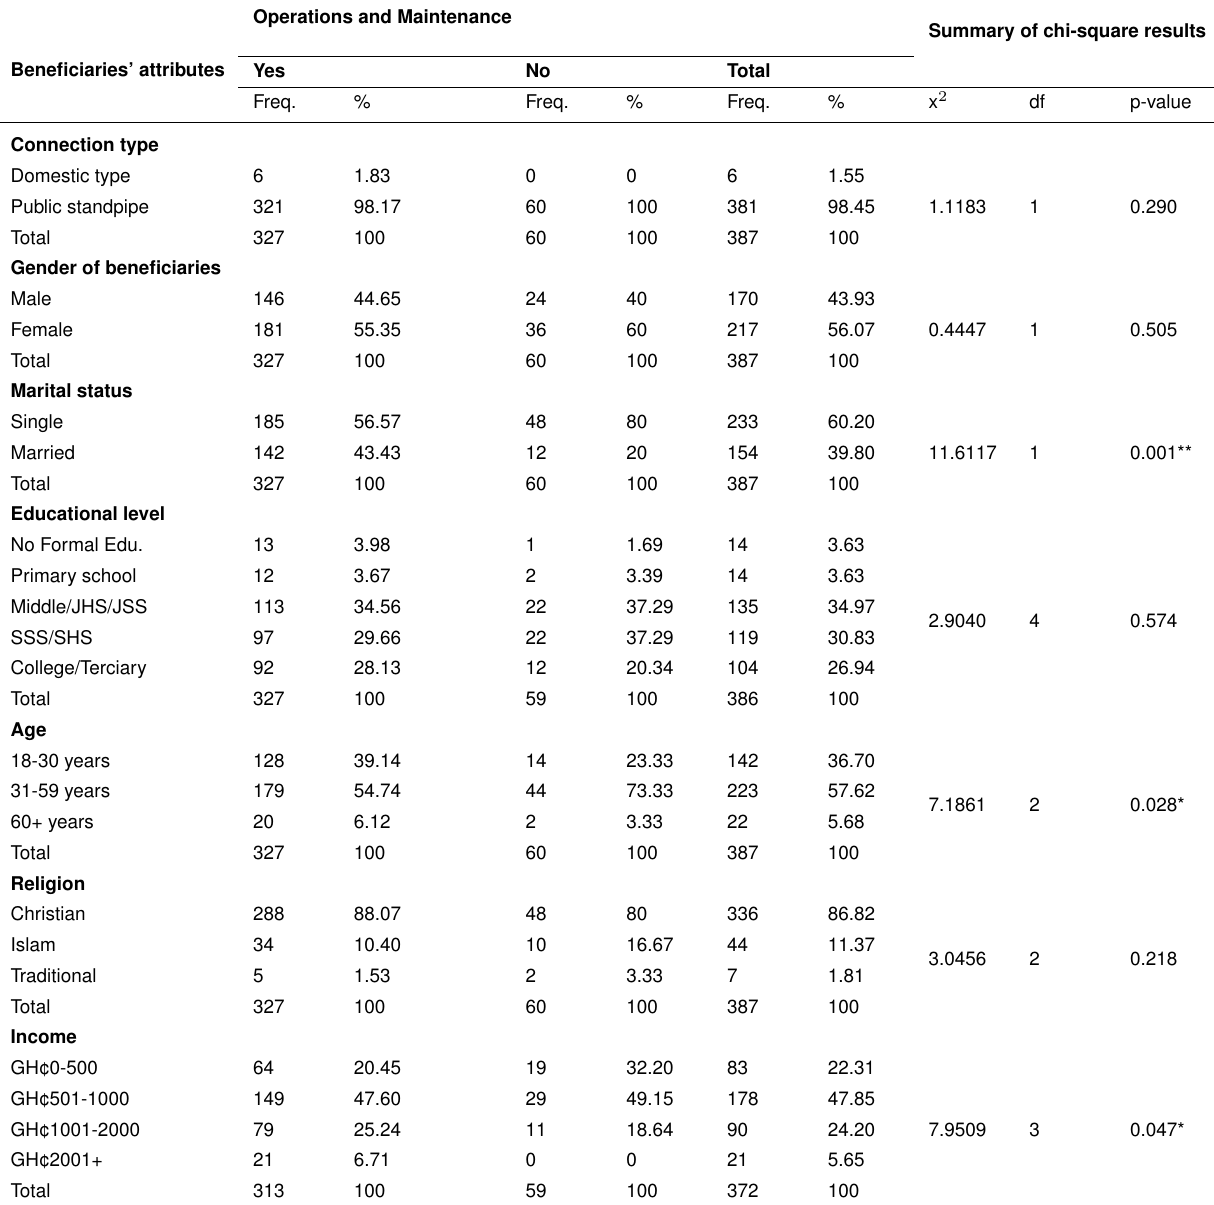
Table 3. Cross-tabulation of beneficiaries’ attributes and perception on system